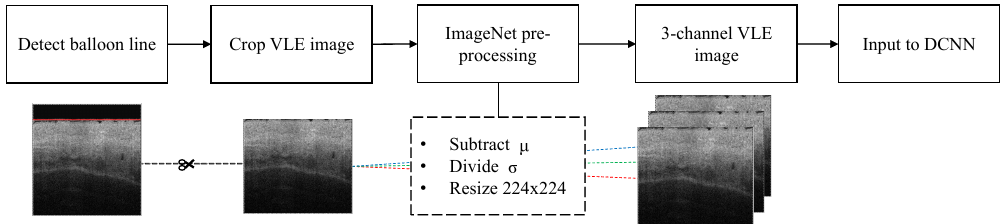
Figure 2. Automatic workflow of the preprocessing applied to each VLE frame. First the balloon line is detected in the VLE frame. Secondly, the image is cropped below the detected balloon line. The VLE image is then resized to 224 × 224. The mean ( µ ) is subtracted and the standard deviation ( σ ) divided according to the pre-trained ImageNet weights. Finally, the gray-scale channel is then triplicated to simulate the RGB requirements of the pre-trained network.